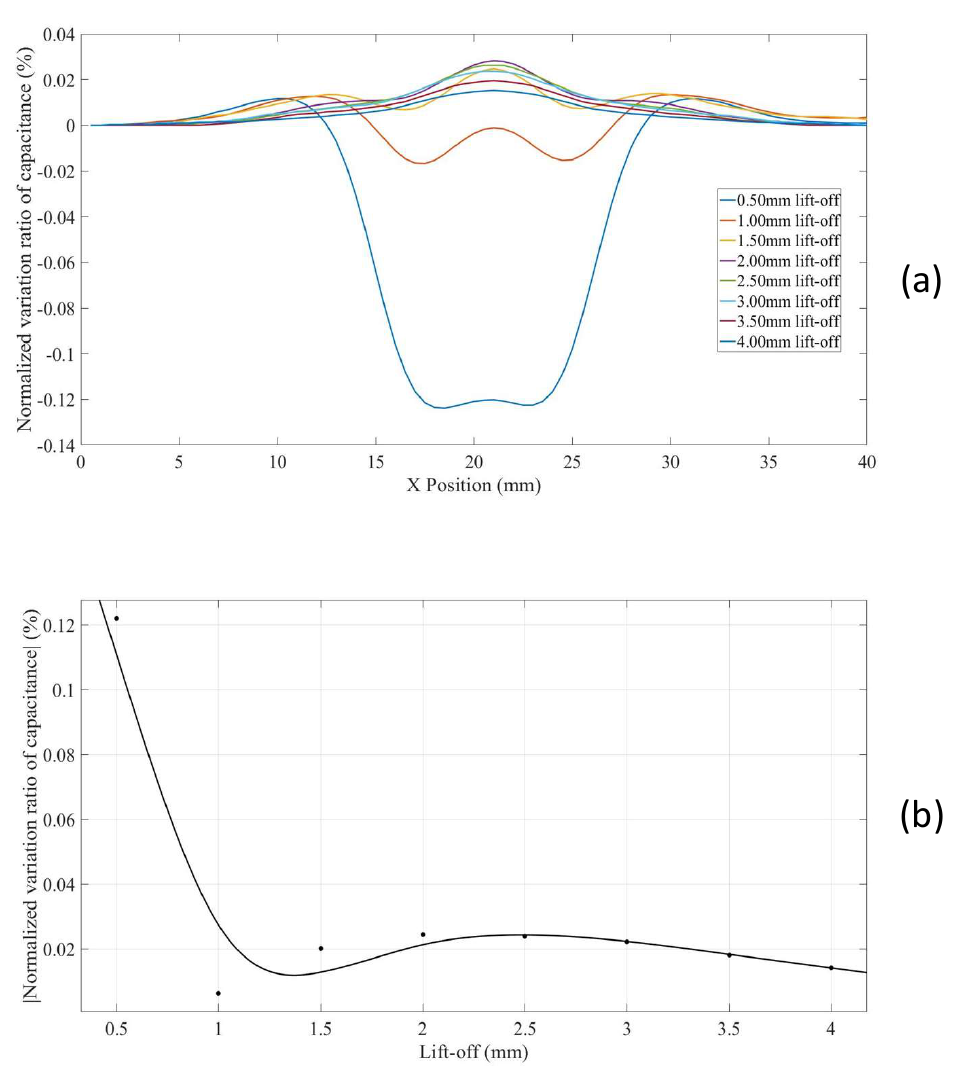
Figure 19. ( a ) NVR curves for the hidden 1.5 mm hole on specimen I (placed on a thick insulation plate) with lift-offs increased from 0.5 mm to 4 mm ( b ) absolute values of the NVRs at the centre point against lift-offs.